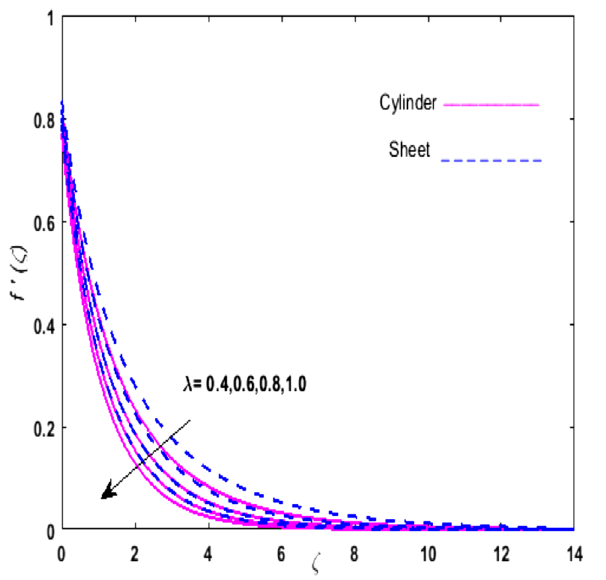
Figure 3. Upshot of (cid:31) on f ′ (ζ)